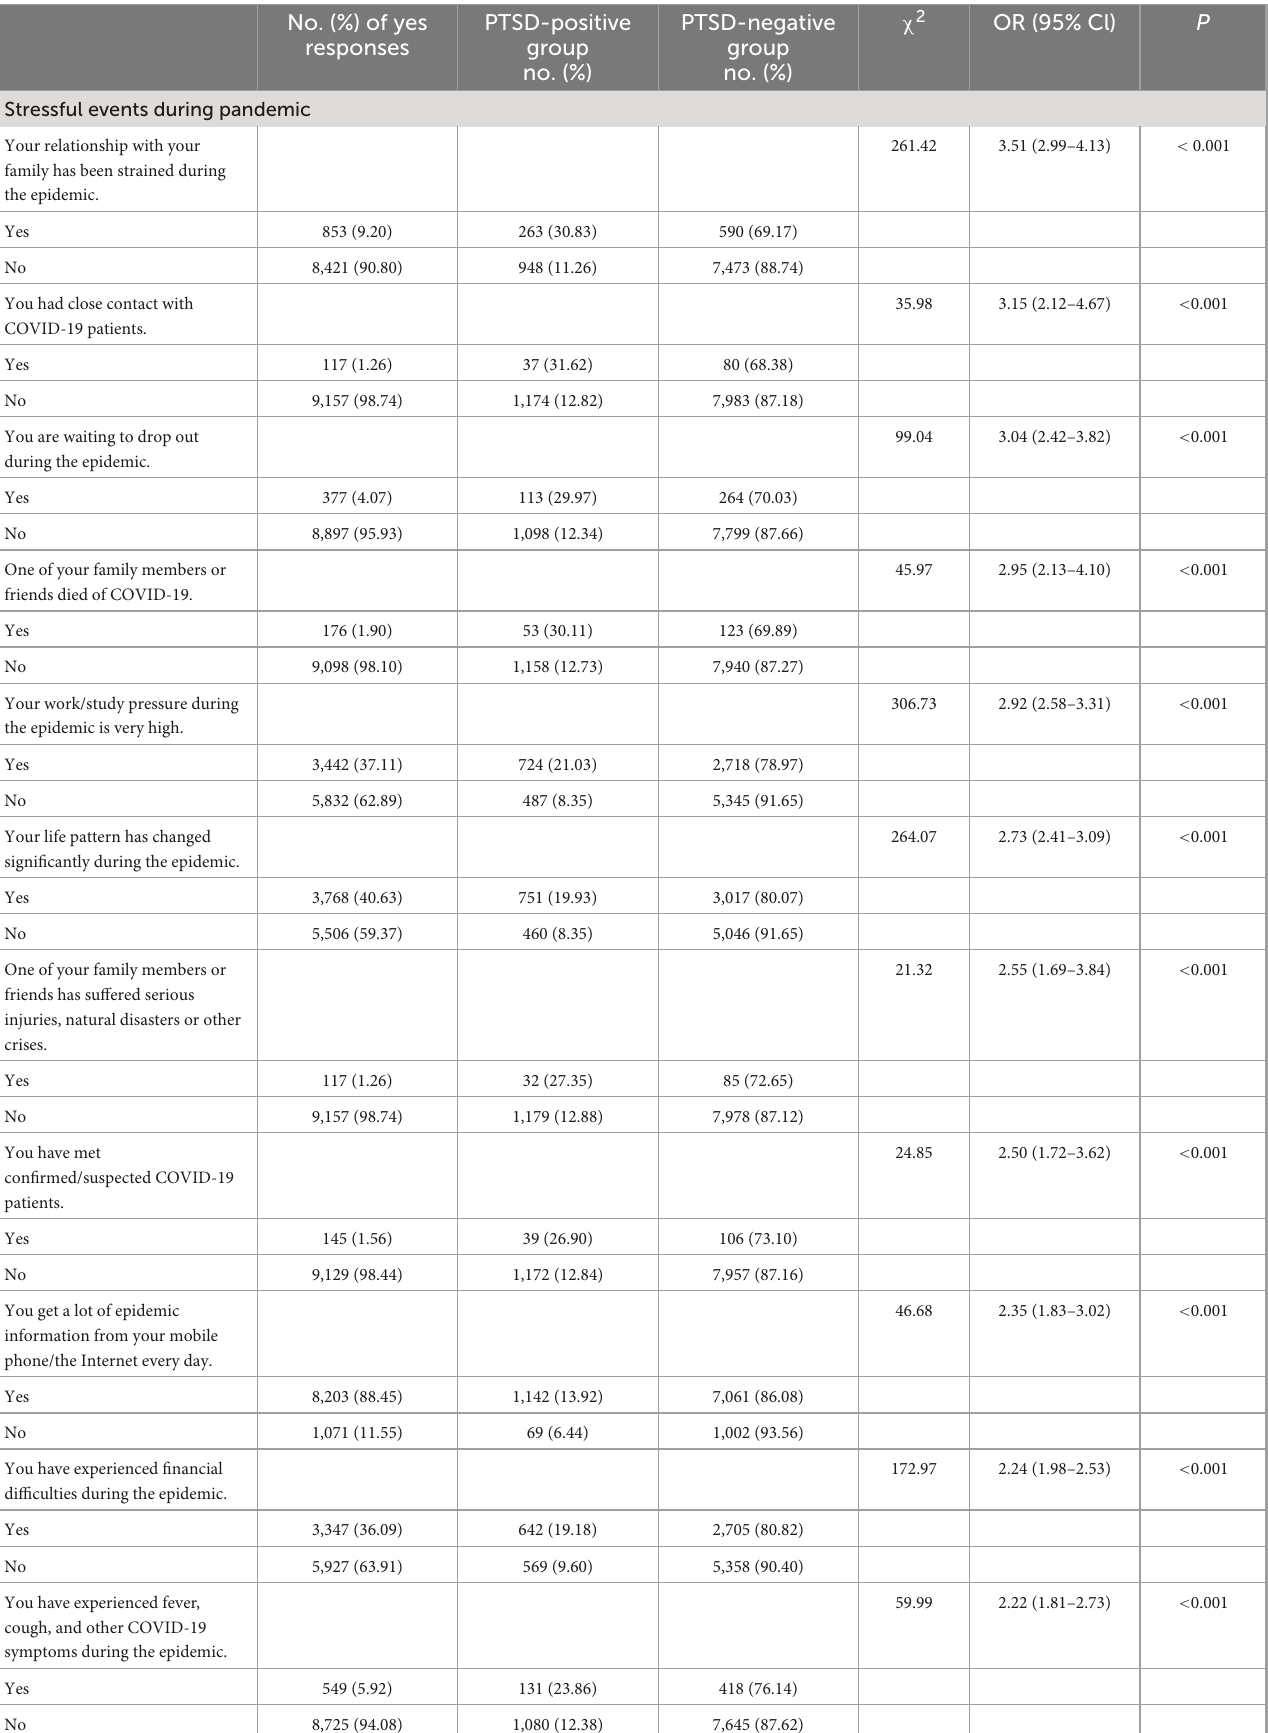
TABLE 4 Correlation between the development of COVID-19-related PTSD symptoms and stressful events.